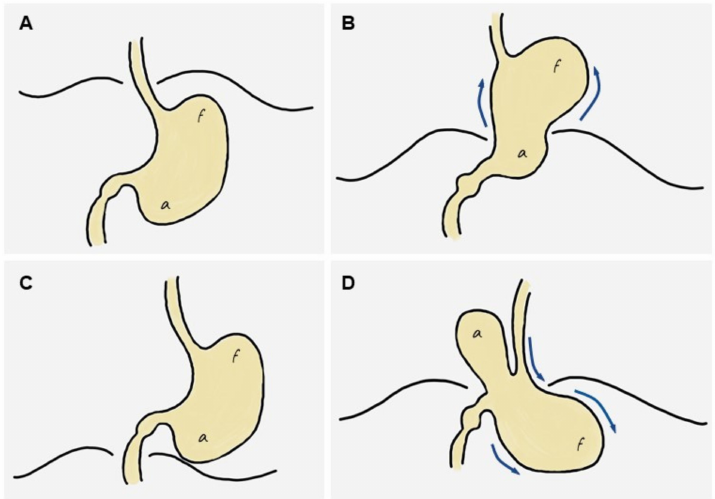
Figure 5. Diagram of the stages leading to the ‘back-and-forth’ stomach. ( A ) Normal stomach. ( B ) A portion of the cardias/fundus slides upwards into the mediastinum, leading to a sliding hiatal hernia, which increases progressively over time to eventually include most or all of the stomach in the mediastinum (including the antrum). ( C ) The entire stomach is located in the mediastinum and may rotate horizontally, predisposing the fundus to re-herniate into the abdomen. ( D ) A downward re-herniation of the fundus into the abdominal cavity through the esophageal hiatus occurs; the antrum normally lies above the diaphragm. The inability of the fundus content to be drained through the hernia neck leads to acute obstruction, i.e., gastric